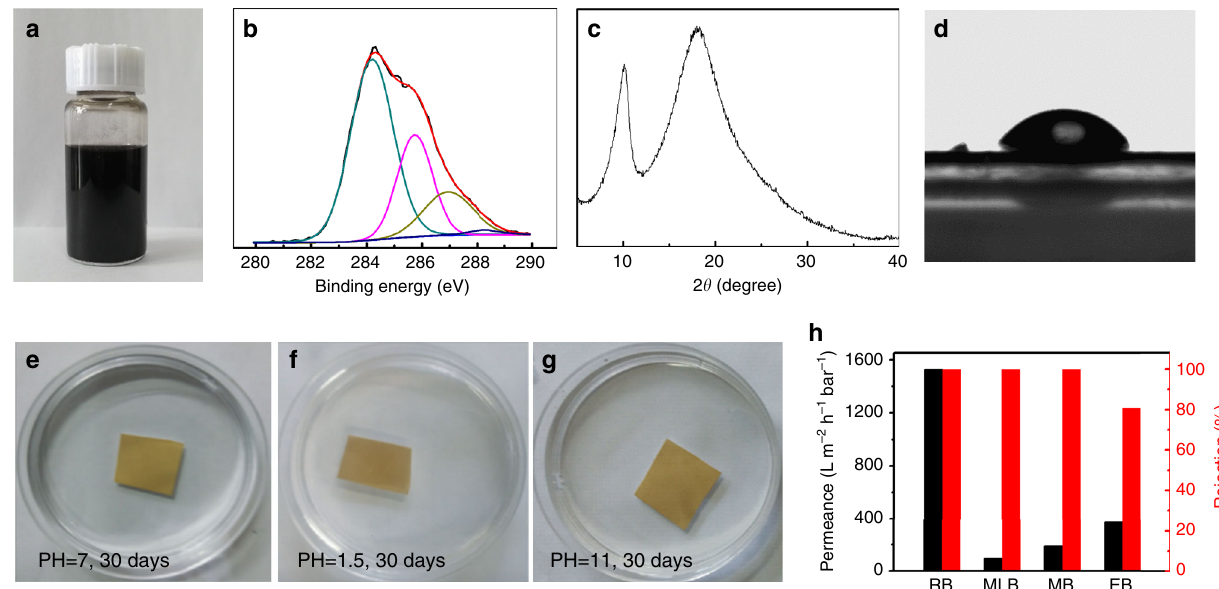
Fig. 4 Structure and performance of rGO – GT membranes. a rGO – GT dispersion. b C 1 s XPS spectra. c XRD pattern. d Photo of a water droplet on rGO – GT membrane surface. e – g Stability in water ( e ), acid solution ( f ), and basic solution ( g ). h Permeance and rejection of organic dyes (1000 ppm) through a ~500-nm-thick rGO – GT membrane at a transmembrane pressure of 1.0